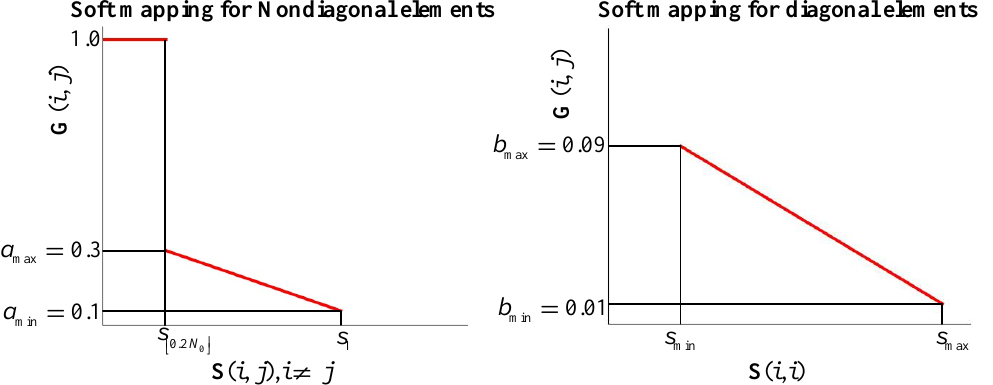
Figure 4. Soft mappings from label similarities S to label differences G .